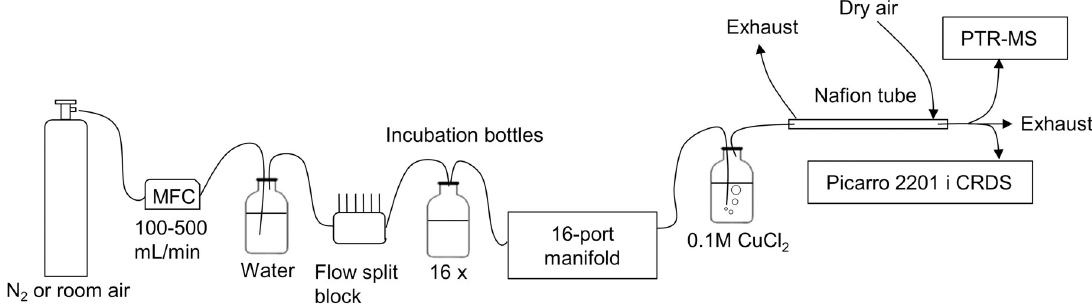
Fig 2. Gas measurement setup with incubation experiments. MFC is mass flow controller; PTR-MS is proton transfer reaction mass spectrometry; CRDS is cavity ring-down spectroscopy.